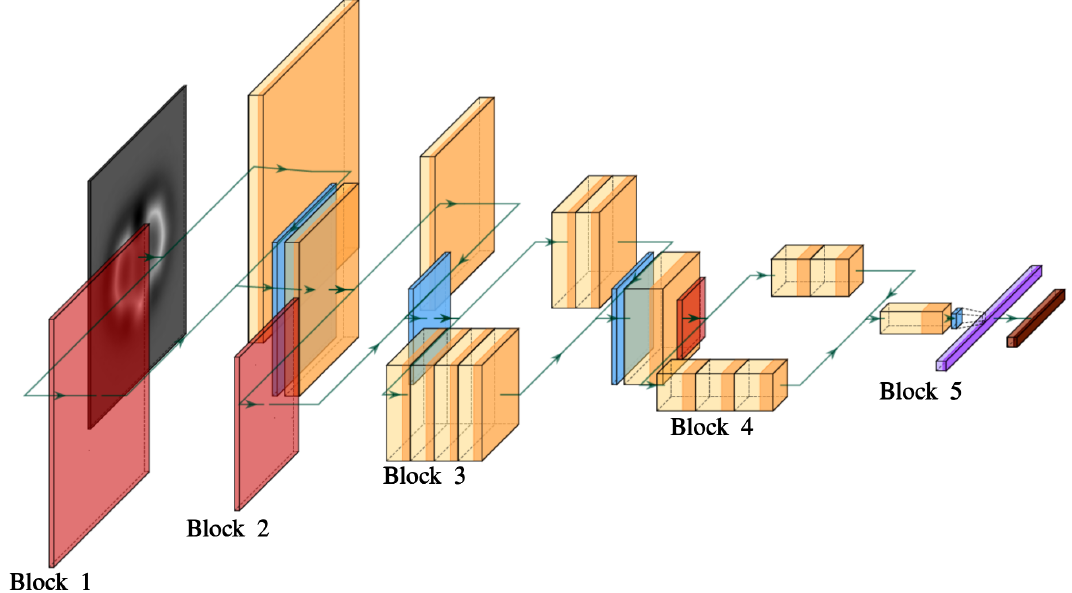
Figure 5. ML-AFM model architecture designed to capture the characteristics of AFM images and to prevent a too specialized training (overfitting) in AFM image classification. The model combines five blocks, each of them with a series of different layers such as convolution (yellow), pool (red) , dropout (blue), flatten (purple), and fully connected (brown) layers. Table A1 provides a detailed description of each layer, including the number and characteristics of all the